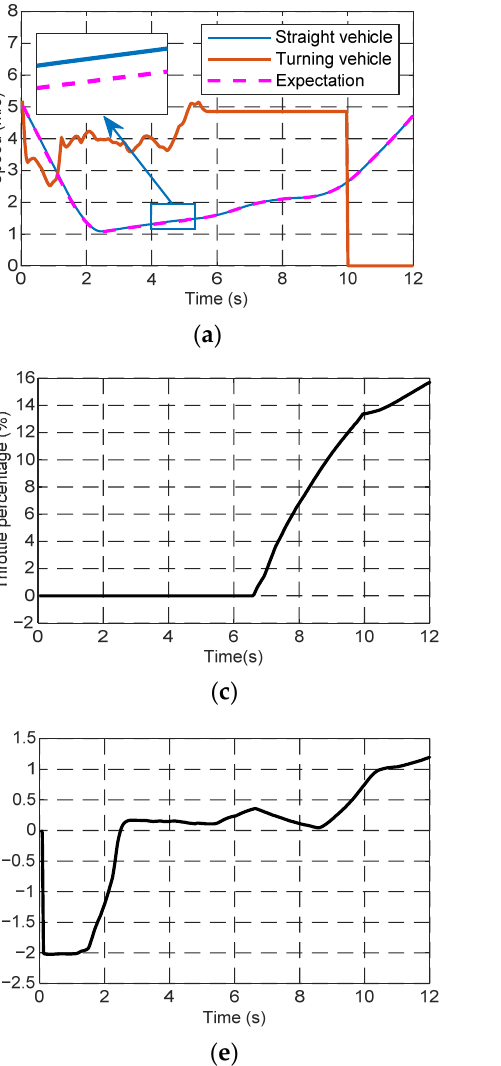
Figure 17. Simulation results of condition I: ( a ) vehicle velocity, ( b ) distance to destination, ( c ) throt- tle curve, ( d ) brake-press curve, ( e ) acceleration curve, and ( f ) distance between two vehicles.